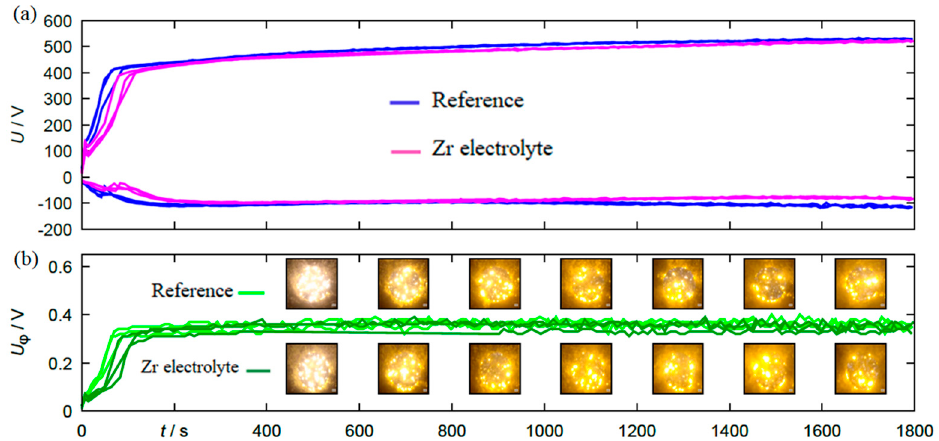
Figure 2. ( a ) The course of anodic and cathodic peak voltage and ( b ) the photo-voltage for specimens coated by PEO process in the reference electrolyte and the Zr electrolyte.